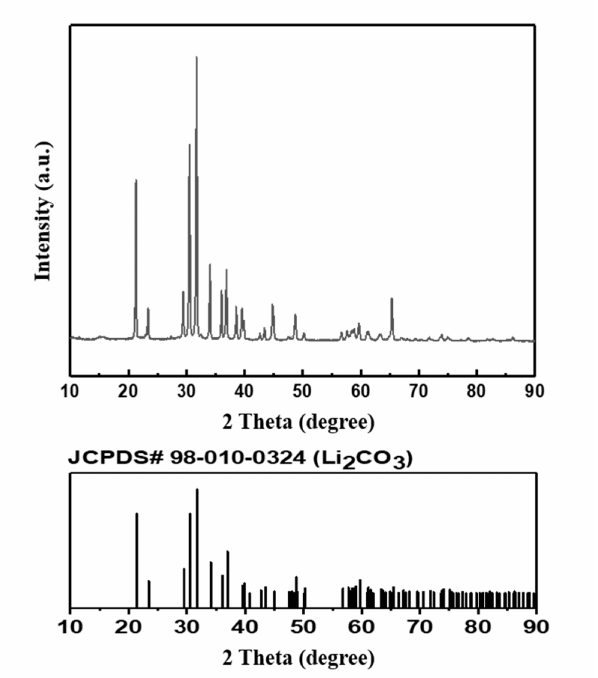
Figure 8. XRD analysis of evaporative concentration after solid–liquid